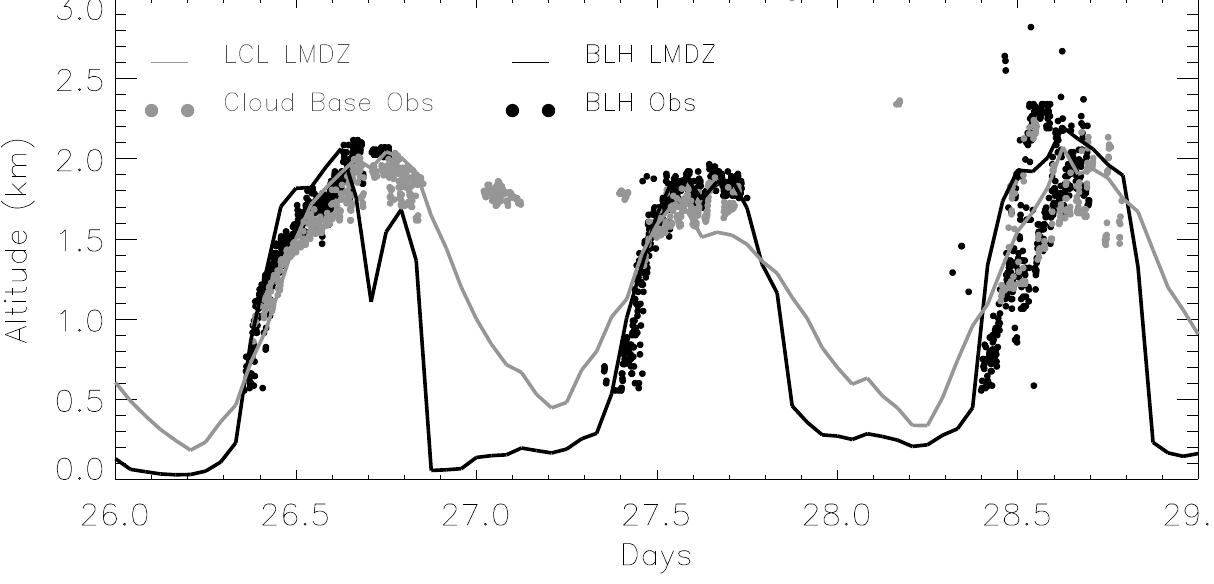
Fig. 10. Evolution of the first cloud base height (grey) and boundary layer height (black). Dots are lidar and ceilometer observations. Solid lines are diagnostics based on LMDZ runs. Three diurnal cycles are represented (26–28 May